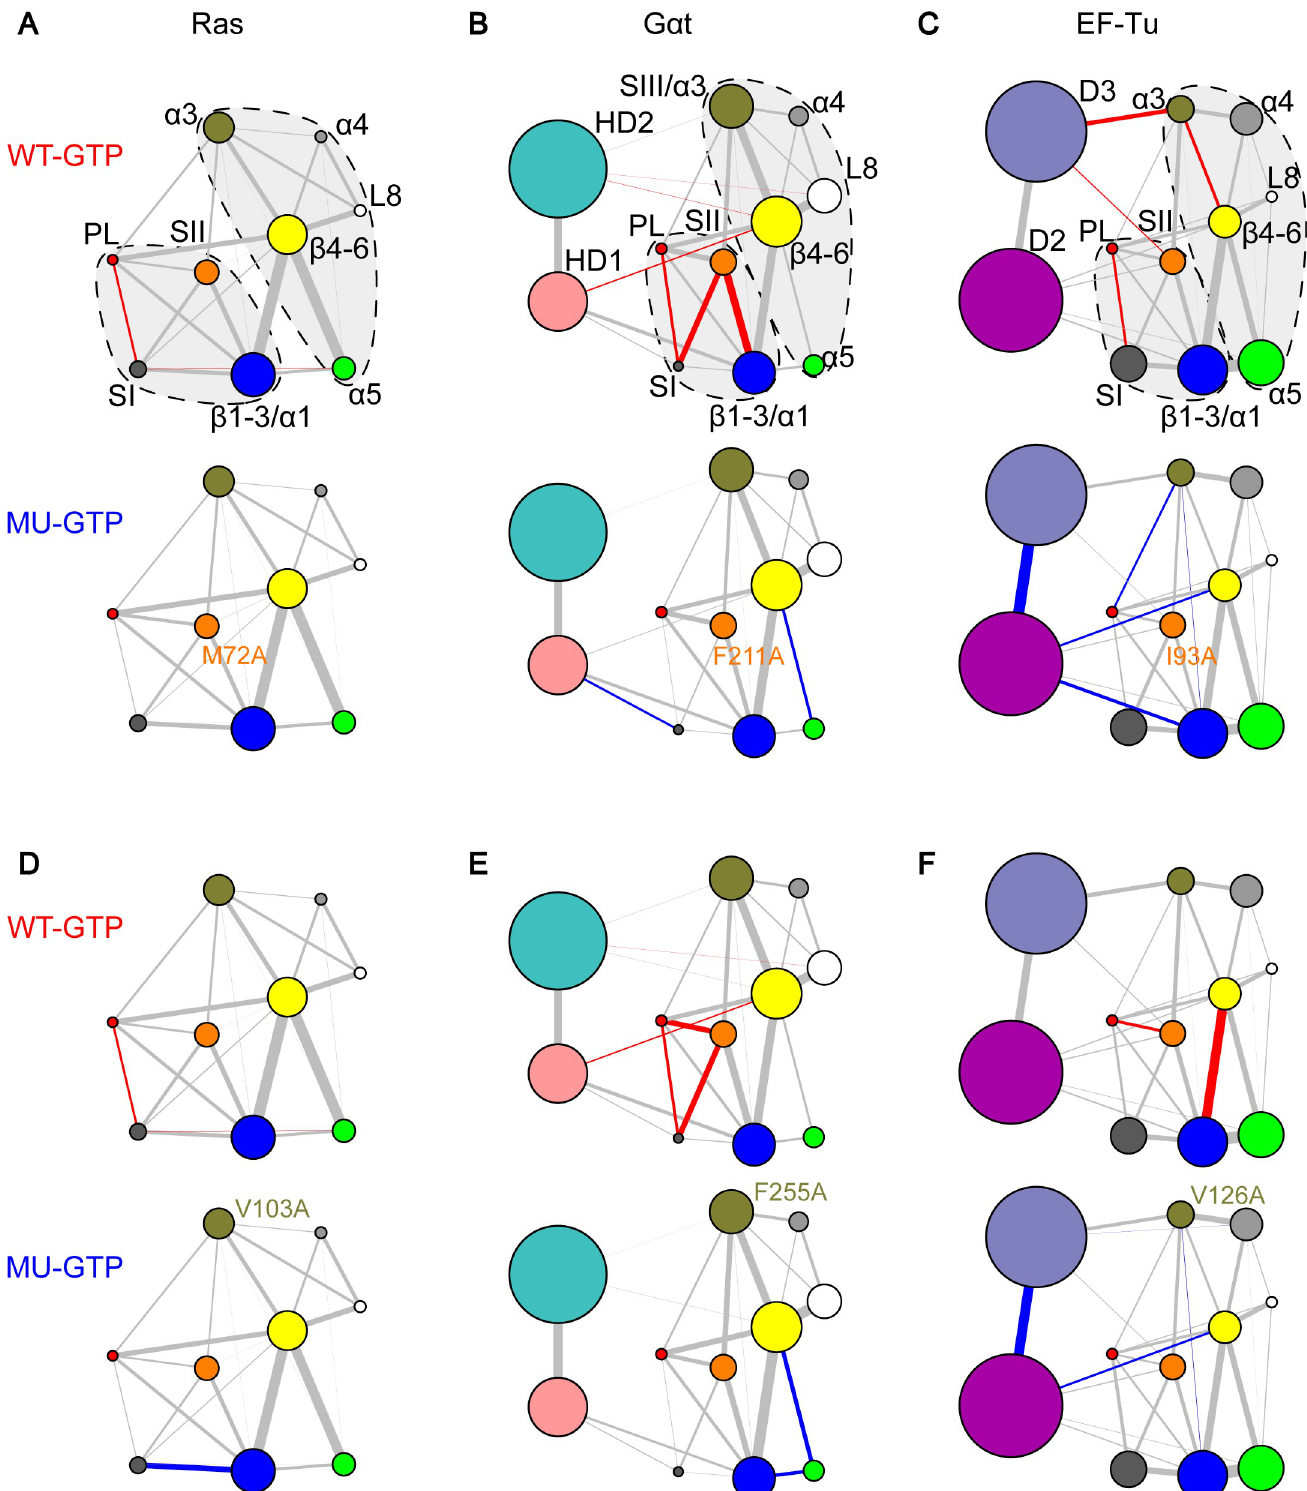
Fig 5. Mutations of common residue-wise determinants of structural dynamics between SII and α 3 have similar effects in Ras, G α t and EF-Tu. Mutations M72A Ras in SII ( A ) and V103A Ras in α 3 ( D ) significantly reduce the couplings between PL and SI. The counterpart mutations in G α t and EF-Tu, F211A G α t in SII ( B ), F255A G α t in α 3 ( E ), I93A EF-Tu in SII ( C ) and V126A EF-Tu in α 3 ( F ) have similar effects in the nucleotide-binding region–significantly reducing the couplings between PL, SI and SII.